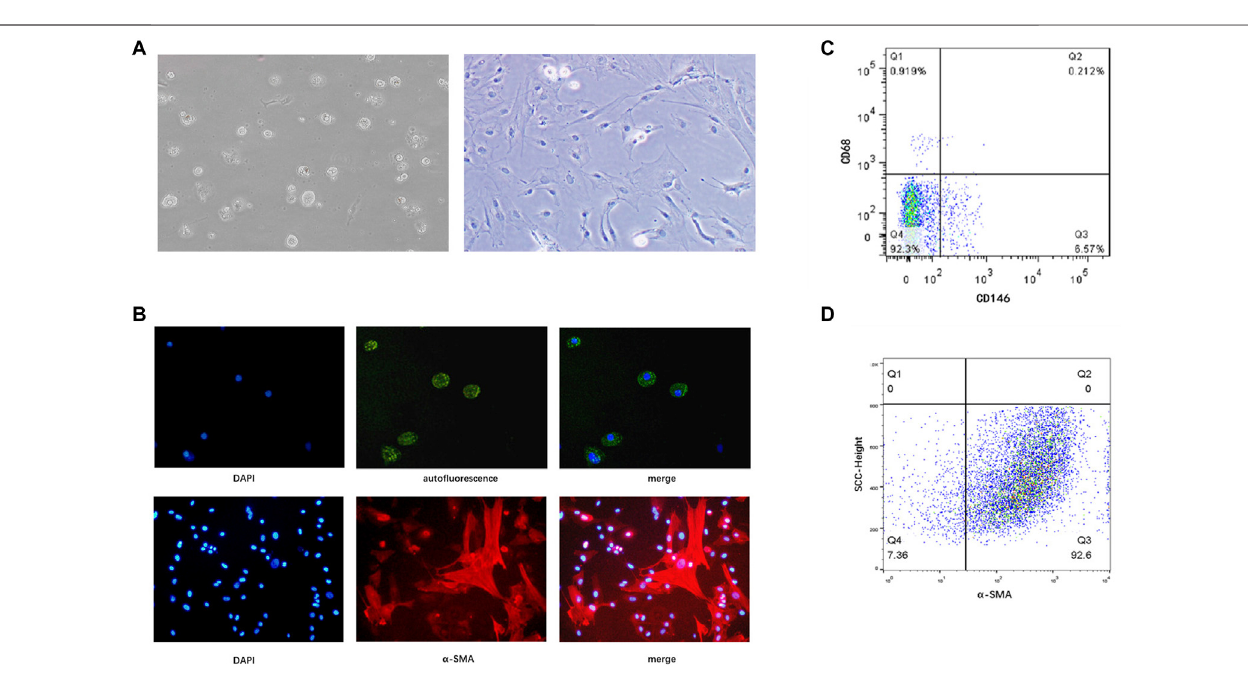
FIGURE 1 | Identi fi cation of primary human HSCs isolated from liver tissue specimens. (A) Freshly isolated primary HSCs (1 d) and HSCs cultured in vitro for 14 days in a light microscopic fi eld at 200× magni fi cation. (B) Spontaneous fl uorescence (green) and DAPI (blue) staining under a laser scanning microscope in a light microscopic fi eld(upperpanels, originalmagni fi cation: ×200),and immuno fl uorescencestainingwithananti- α -SMAantibody(red)and DAPI(blue;lowerpanels, original magni fi cation: ×200). (C) Purity of freshly isolated human HSCs determined by fl ow cytometry. CD146 identi fi es liver endothelial cells, and CD68 identi fi es macrophages. Cells that express neither CD68 nor CD146 are considered HSCs (D) Purity of culture-induced activated HSCs determined by fl ow cytometry. HSCs, hepatic stellate cells.